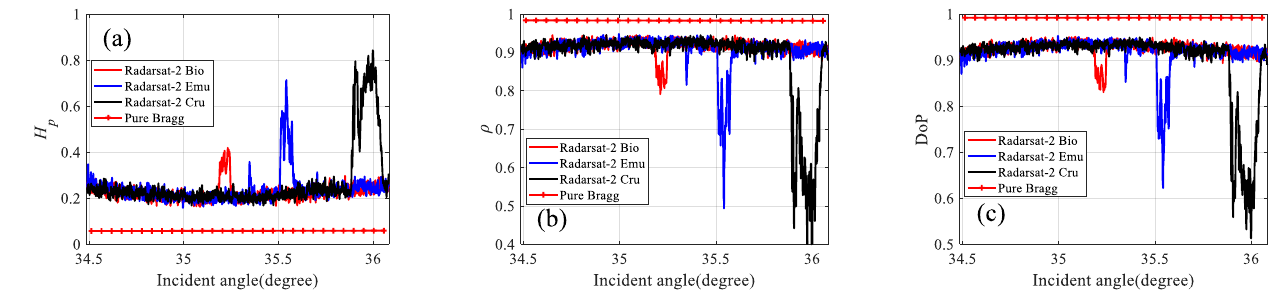
Figure 10. Comparisons of the multi-polarization features derived from the Radarsat-2 image with those predicted by Bragg scattering theory: ( a ) polarimetric entropy ( H p ), ( b ) the co-polarization correlation coefficient ( ρ ), and ( c ) the degree of polarization (DoP).